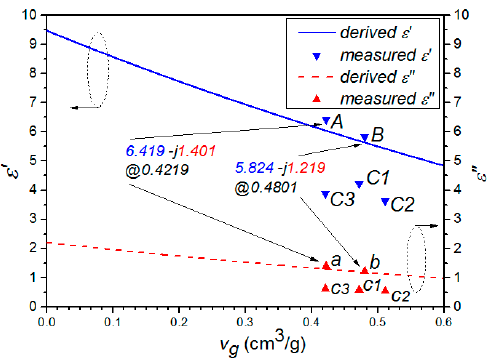
Figure 2. Theoretical and experimental comparison graph between ε eff ( ε ’-j ε ”) and v g .